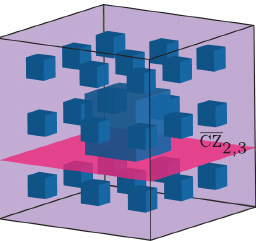
FIG. 34. A transversal logical gate CZ 2,3 between copy 2 and copy 3 in the stack code hence be chosen to be applied on a brane perpendicular to the z direction, avoiding all the holes. Similarly, CZ 1,2 and CZ 1,3 can be applied on a brane perpendicular to the y and x directions,